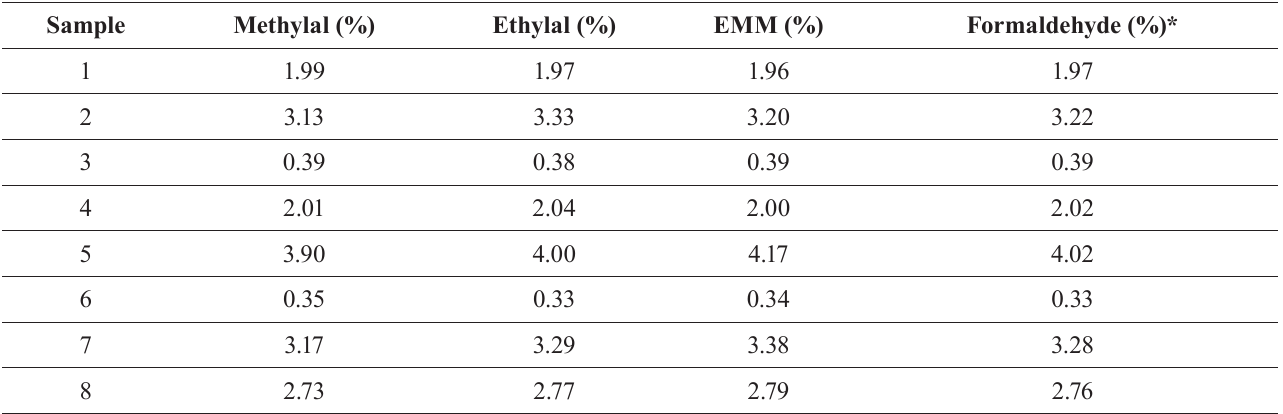
TABLE II - Formaldehyde concentration (%) in hair straightener cream samples analyzed by HS-GC-MS estimated from the derivatized products, methylal, ethoxymethoxymethane (EMM), and ethylal Sample Methylal (%) Ethylal (%) EMM (%) Formaldehyde